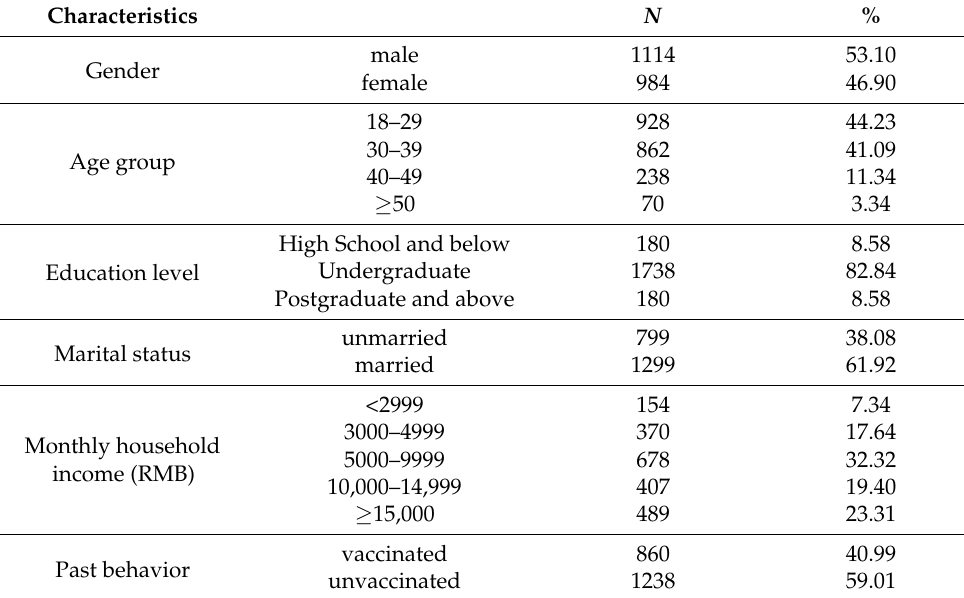
Table 2. Characteristics of the participants ( N =